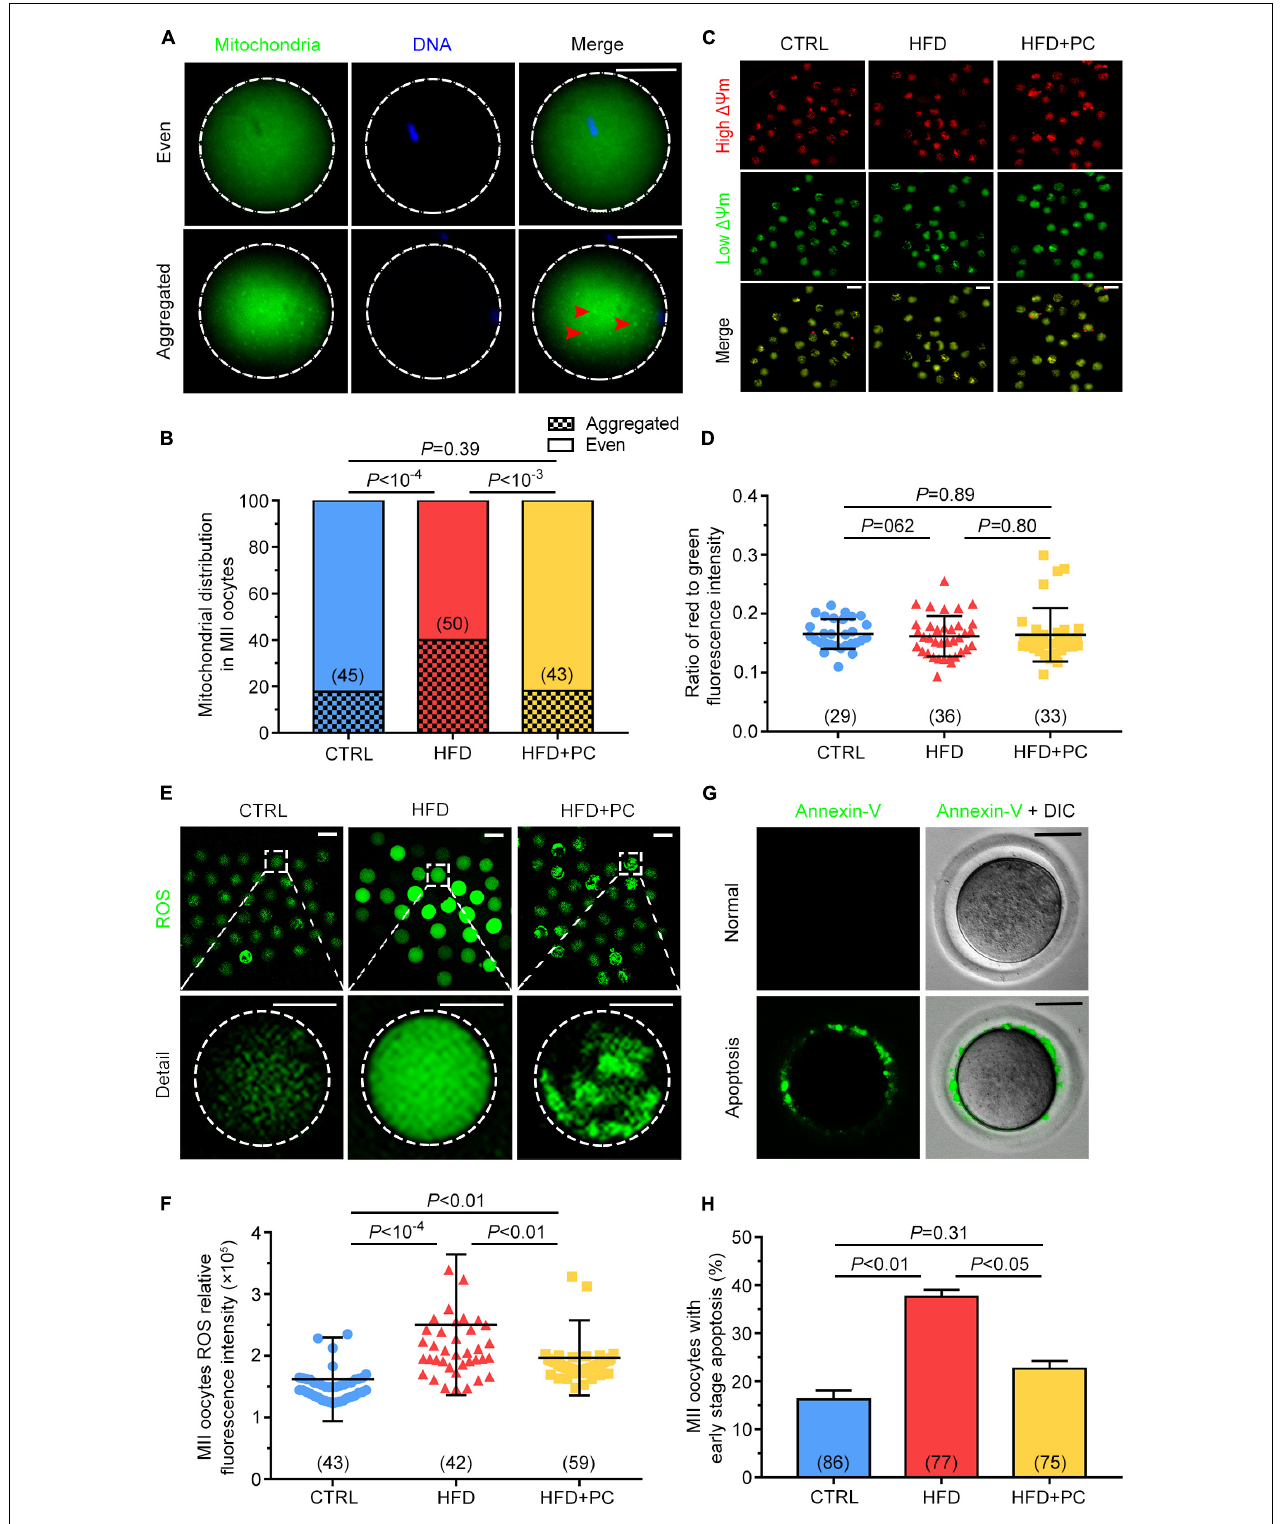
FIGURE 6 | PC restored the mitochondrial distribution in oocytes, and attenuated oxidative stress and early apoptosis in obese mice. (A) Representative images of mitochondria with even or aggregated distributions. Red arrows indicate aggregated mitochondria. Green, mitochondria; blue, DNA. The circular white frame